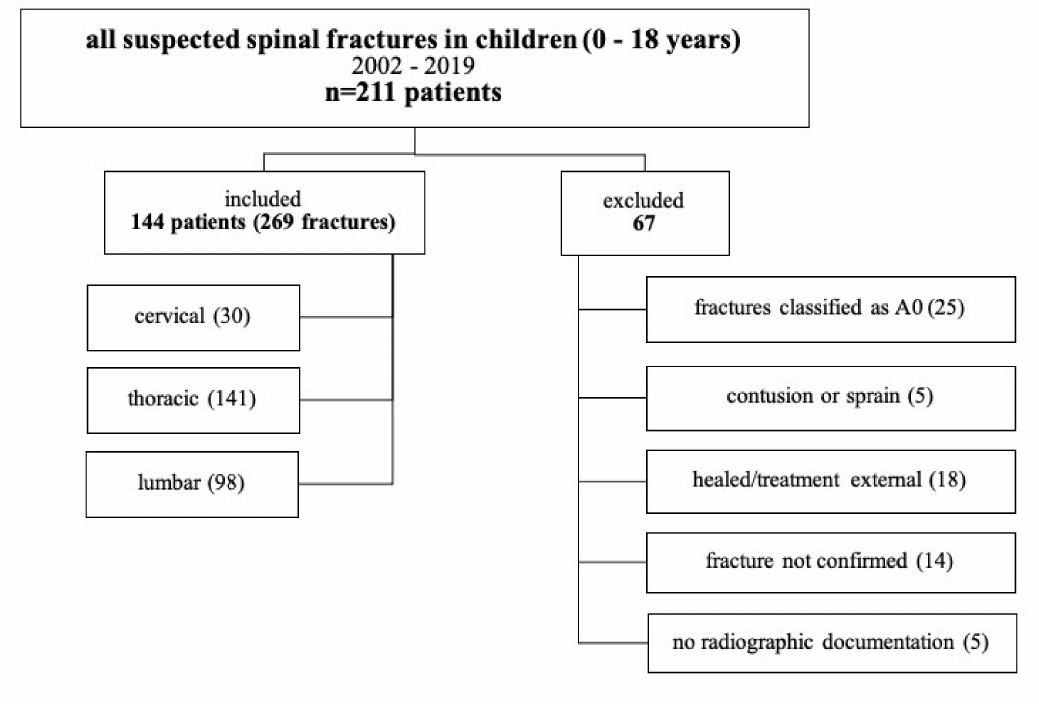
Figure 1. Flow chart of the overall study population (A0 = minor non-structural fractures; MRI, morphologically detectable “bone bruise” as well as spinous and transverse process